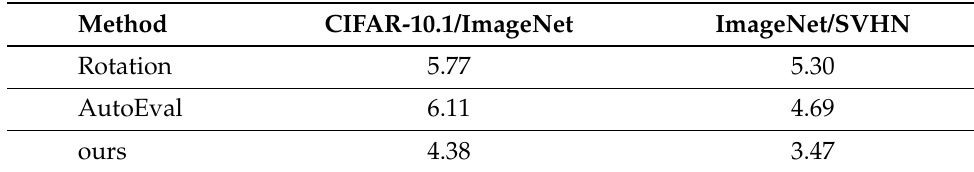
Table 2. The performance of various methods on VGG-16 classifier. ID data/OD data are CIFAR- 10.1/ImageNet, ImageNet/SVHN. RMSE(%) is shown: lower is better.